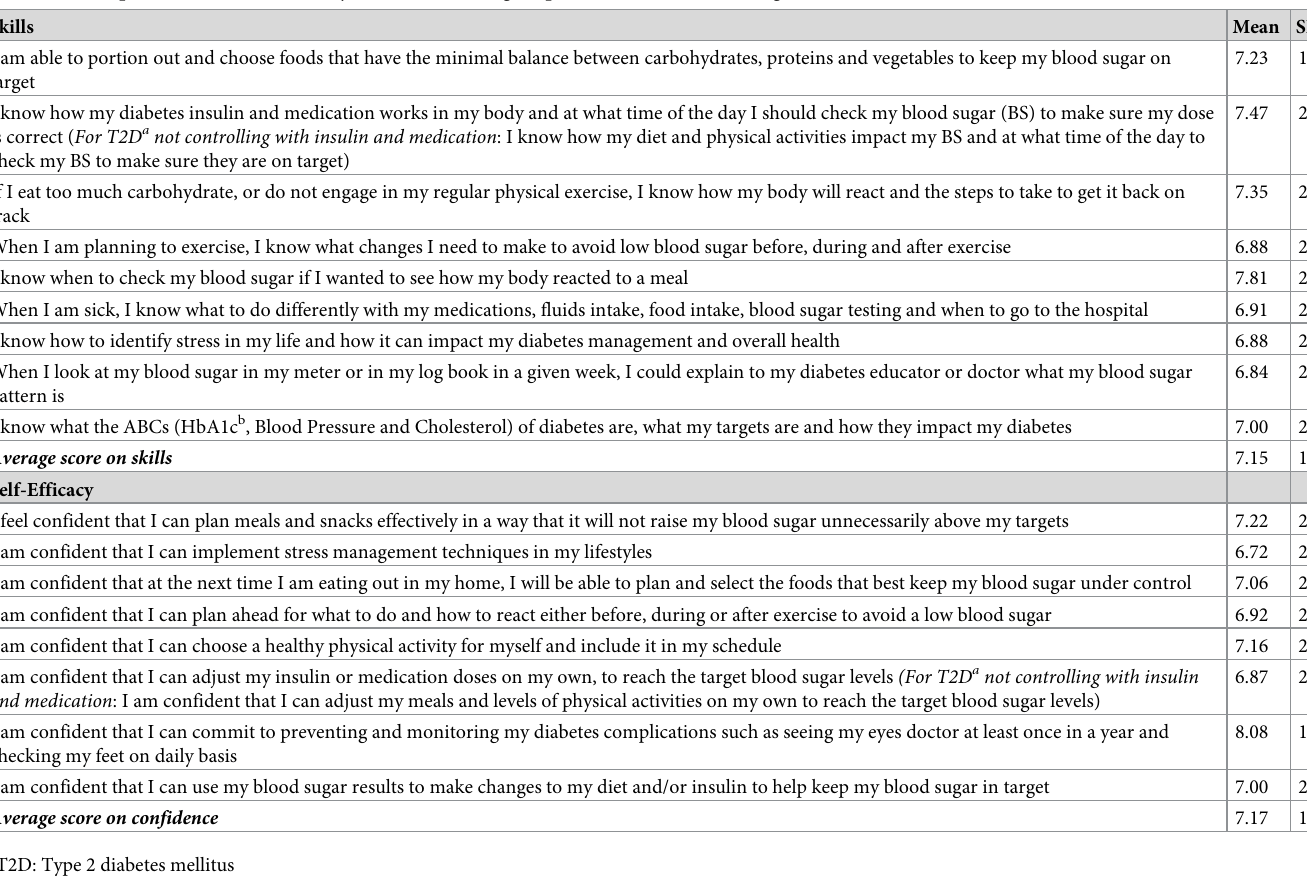
Table 1. Participants skills and self-efficacy (confidence) ratings to perform diabetes